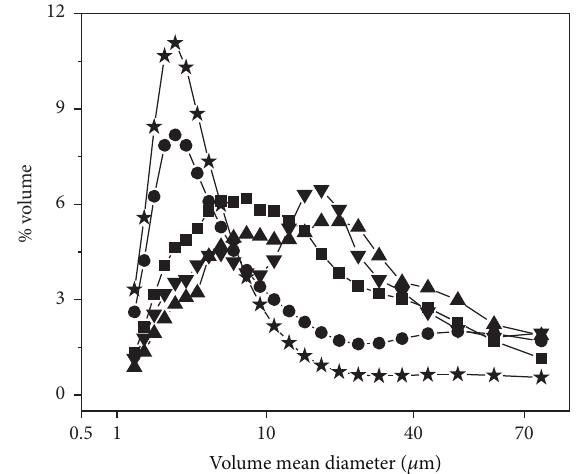
Figure 2: Diameter distribution of oil bodies extracted from different peanut varieties ( ◼ yuhua23 , e yuhua27 , 󳵳 yuhua9719 , 󳶃 yuhua9830 , and ‰ yuhua9502 ). Results are expressed as the percentage of the total volume of all the lipid